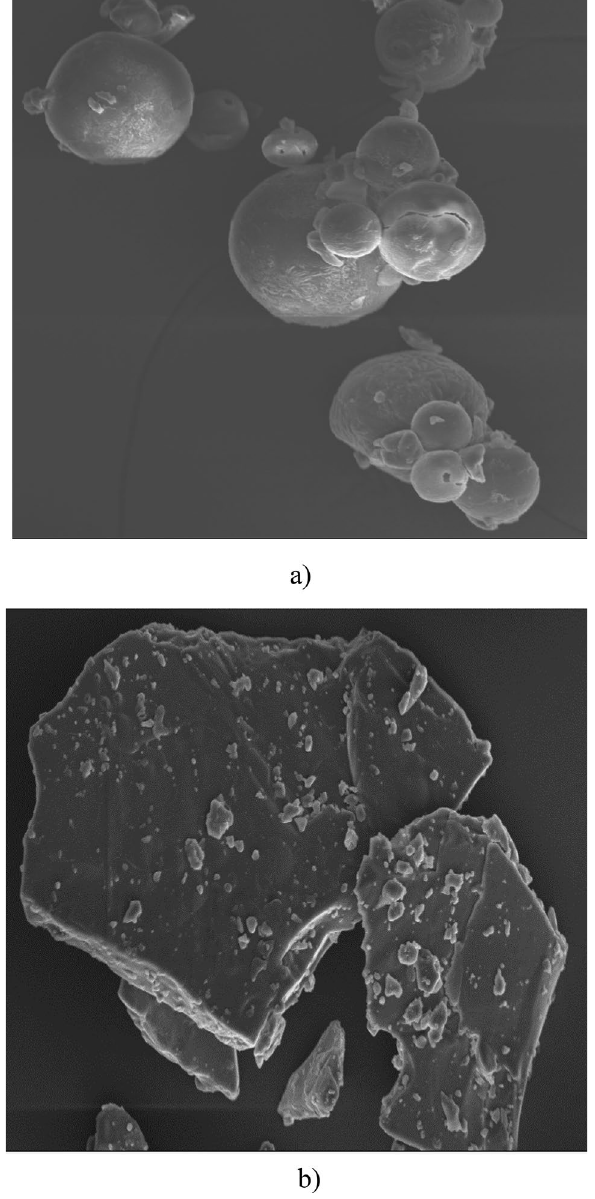
Figure 2. Scanning electron micrographs of ( a ) optimized dry mix (ODM), and ( b ) market dry mix